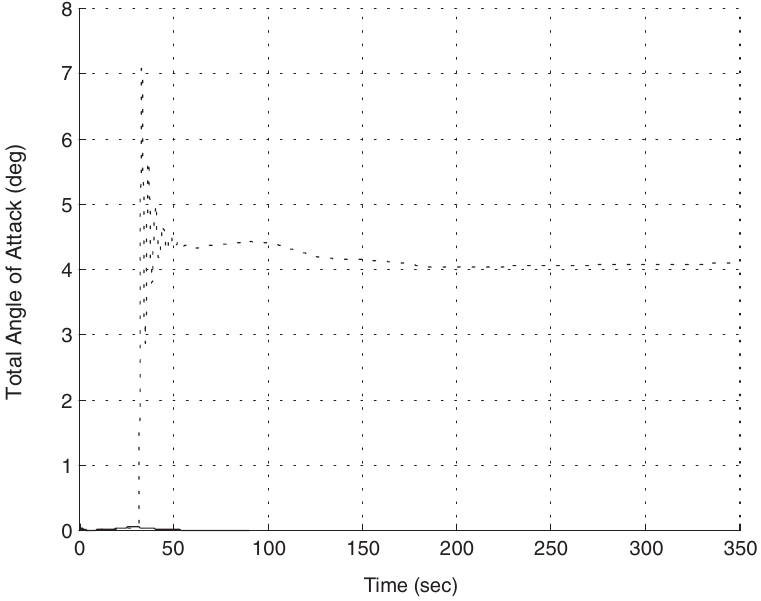
Fig. 11. Total angle of attack vs. time (Solid = Nominal, Dotted = Extended).